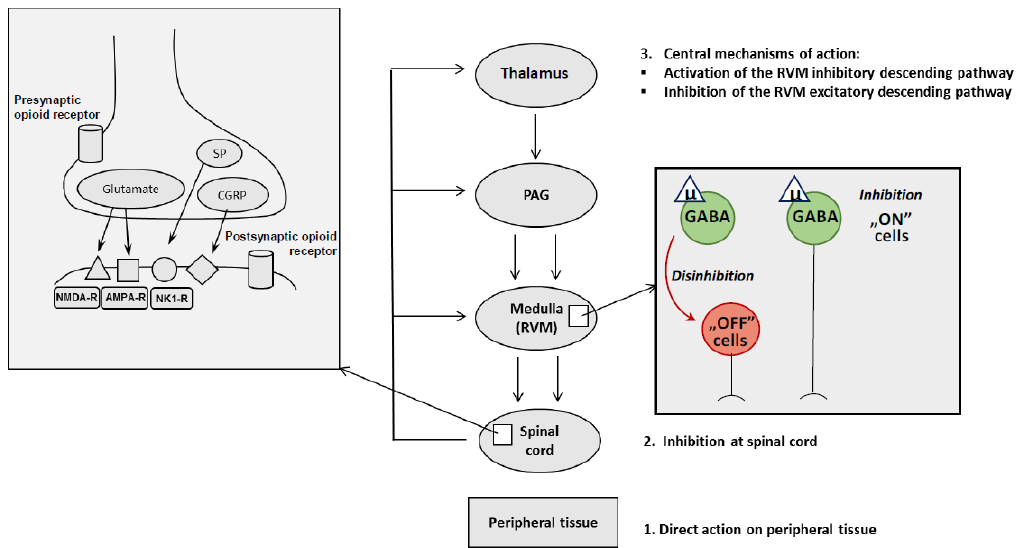
Figure 2. Mechanisms of morphine analgesia. Regarding the supraspinal level, opioid analgesics stimulate the µ receptors located on GABAergic interneurons in the RVM decreasing GABA release. GABA suppresses the “OFF” cells in the RVM, which subsequently raises the action potential. Additionally, opioid-induced activation of µ opioid receptors on GABAergic “ON” cells in the RVM inhibits the firing of these cells. Observed at the spinal level, opioid-induced analgesia is mediated by the activation of presynaptic µ opioid receptors localized in the dorsal horn of the spinal cord. PAG– periaqueductal gray in midbrain; RVM – rostral ventromedial medulla; GABA – gamma-aminobutyric acid; SP – substance P; CGRP – calcitonin gene-related peptide; NMDA-R – N-methyl-D-aspartate receptor;